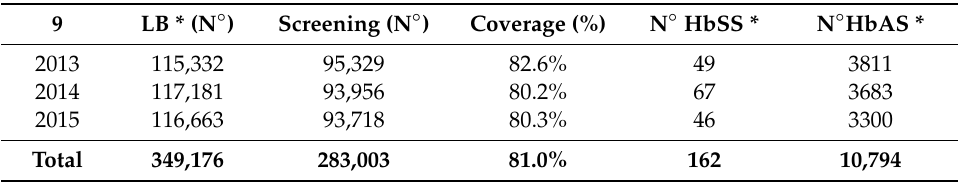
Table 1. Neonatal screening coverage and the total number of sickle cell anaemia and sickle-trace cases in newborns in the State of Maranh ã o, 2013–2015.